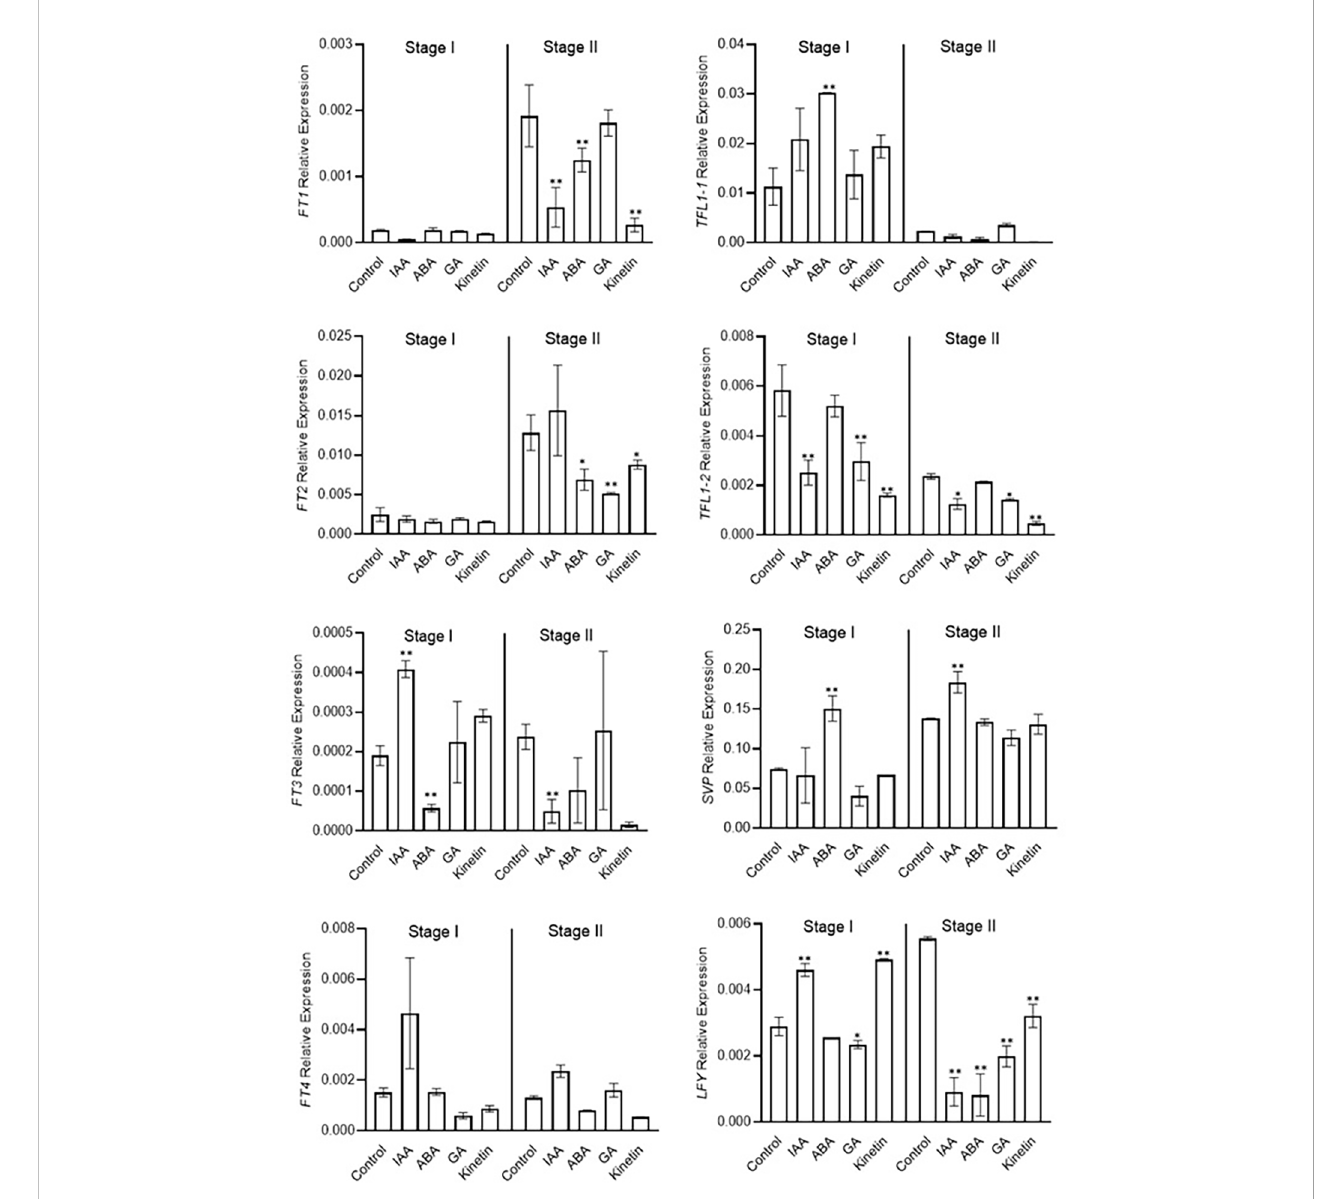
FIGURE 4 Expression pro fi ling of genes involved in fl owering induction quanti fi ed by real-time PCR in response to different hormones. Total RNA was isolated from the apical bud of corms treated with different hormones at 45 days (stage I) and 90 days (stage II) of treatments. Reactions from three separate pools of apical bud RNA samples were run in triplicates with tubulin as the internal control for normalization. Error bars represent ± SD of three biological replicates. Stage I morphologically represents the fl ower induction stage, and stage II represents the stamen and stigma formation stage. Data represented is mean of three biological replicates. Error bars represent standard error (SE), * indicates P <0.05, ** indicates P <0.01, with respect to control (Student ’ s